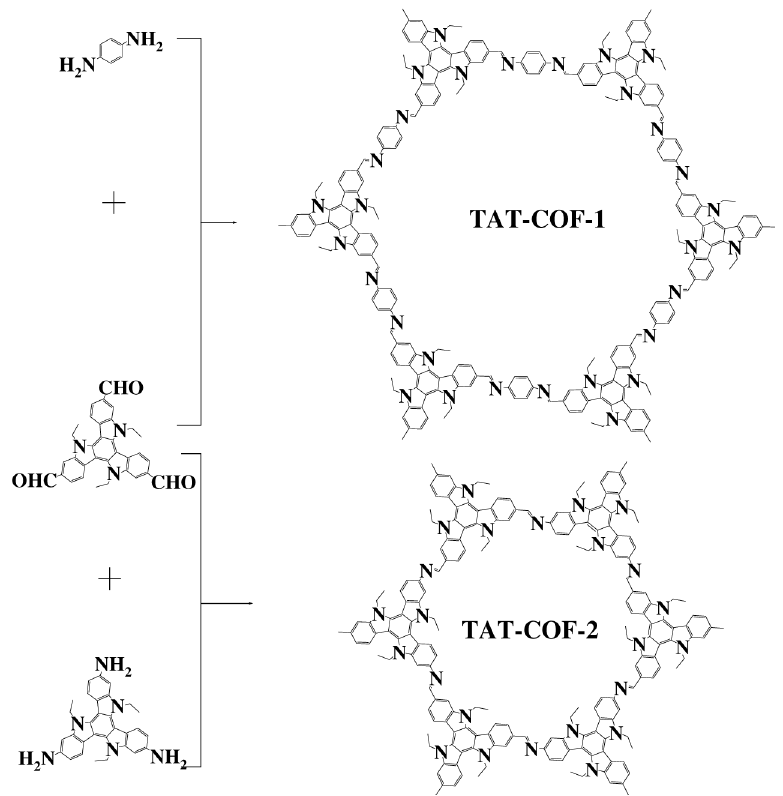
Figure 19: Synthesis and structure ofTAT-COF-1 and